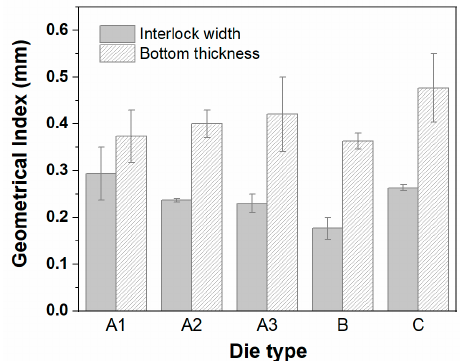
Figure 11. Geometrical indices for SPR joint of Al5052-H32 (top) and vibration-damping steel (bottom) with respect to SPR die type.